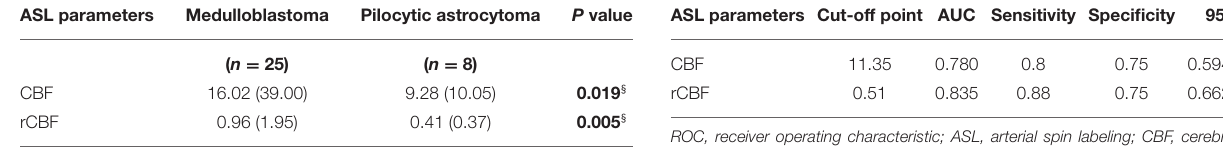
TABLE 1 | Comparison of ASL parameters between medulloblastoma and pilocytic astrocytoma. ASL parameters